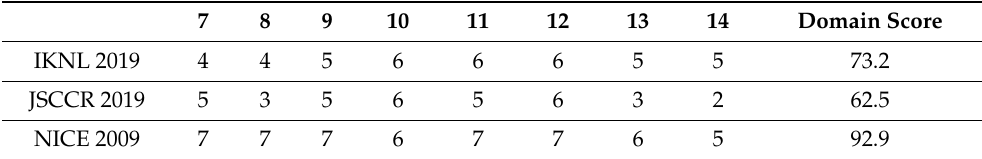
Table A1. (Inter)national guideline organizations and scientific societies reviewed according to the AGREE-II*